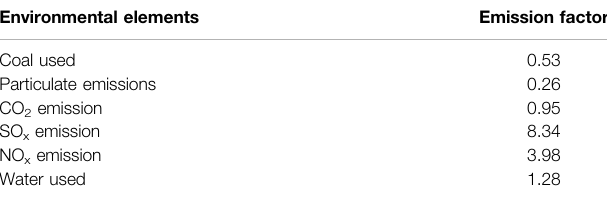
TABLE 2 | Emission factors of various environmental elements (Eskom, 2019). Environmental